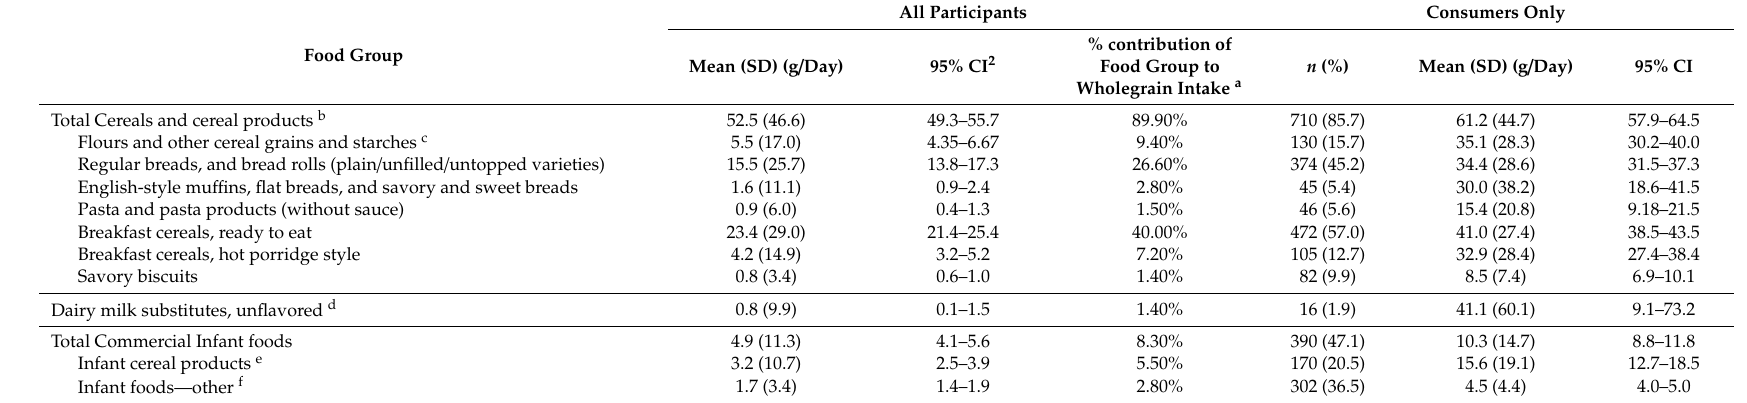
Table 2. Food group contribution to usual wholegrain intake for all children ( n = 828) and for food group consumers